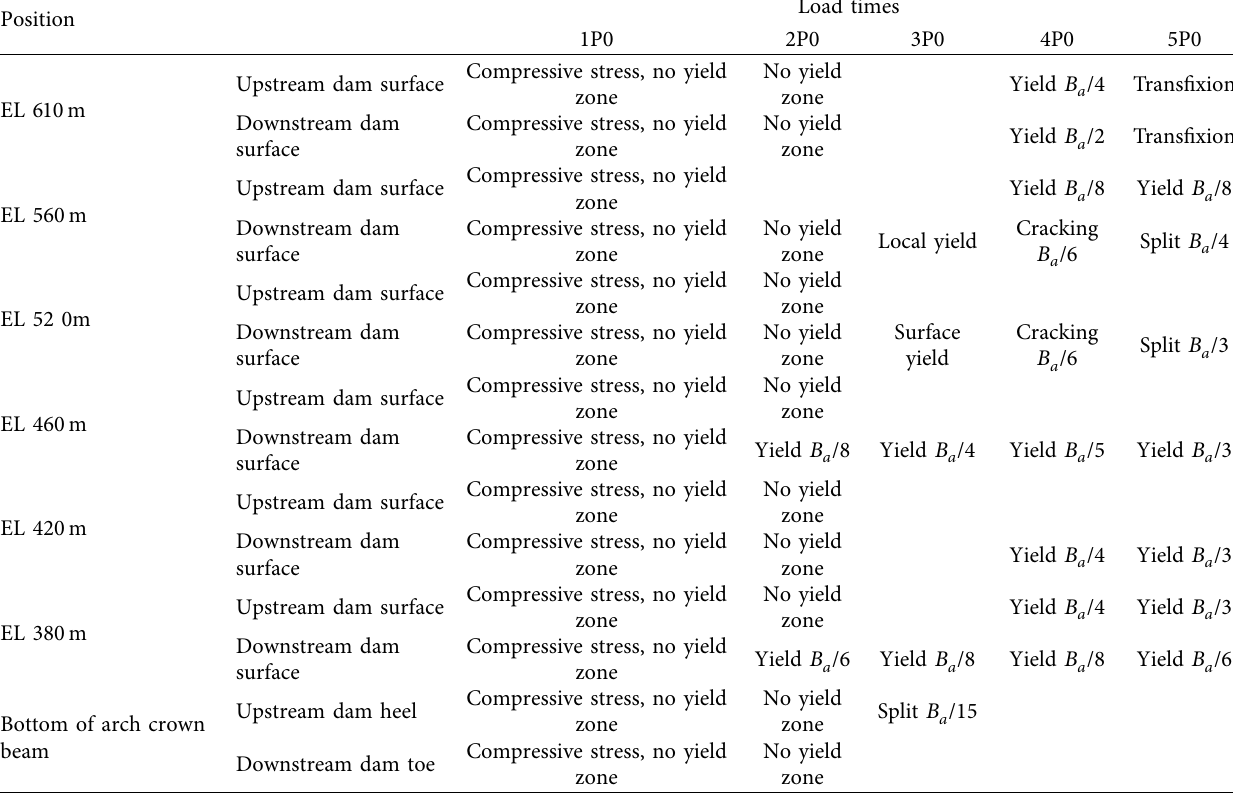
Table 8: Yield and cracking state of each elevation of the dam under overload conditions. Position